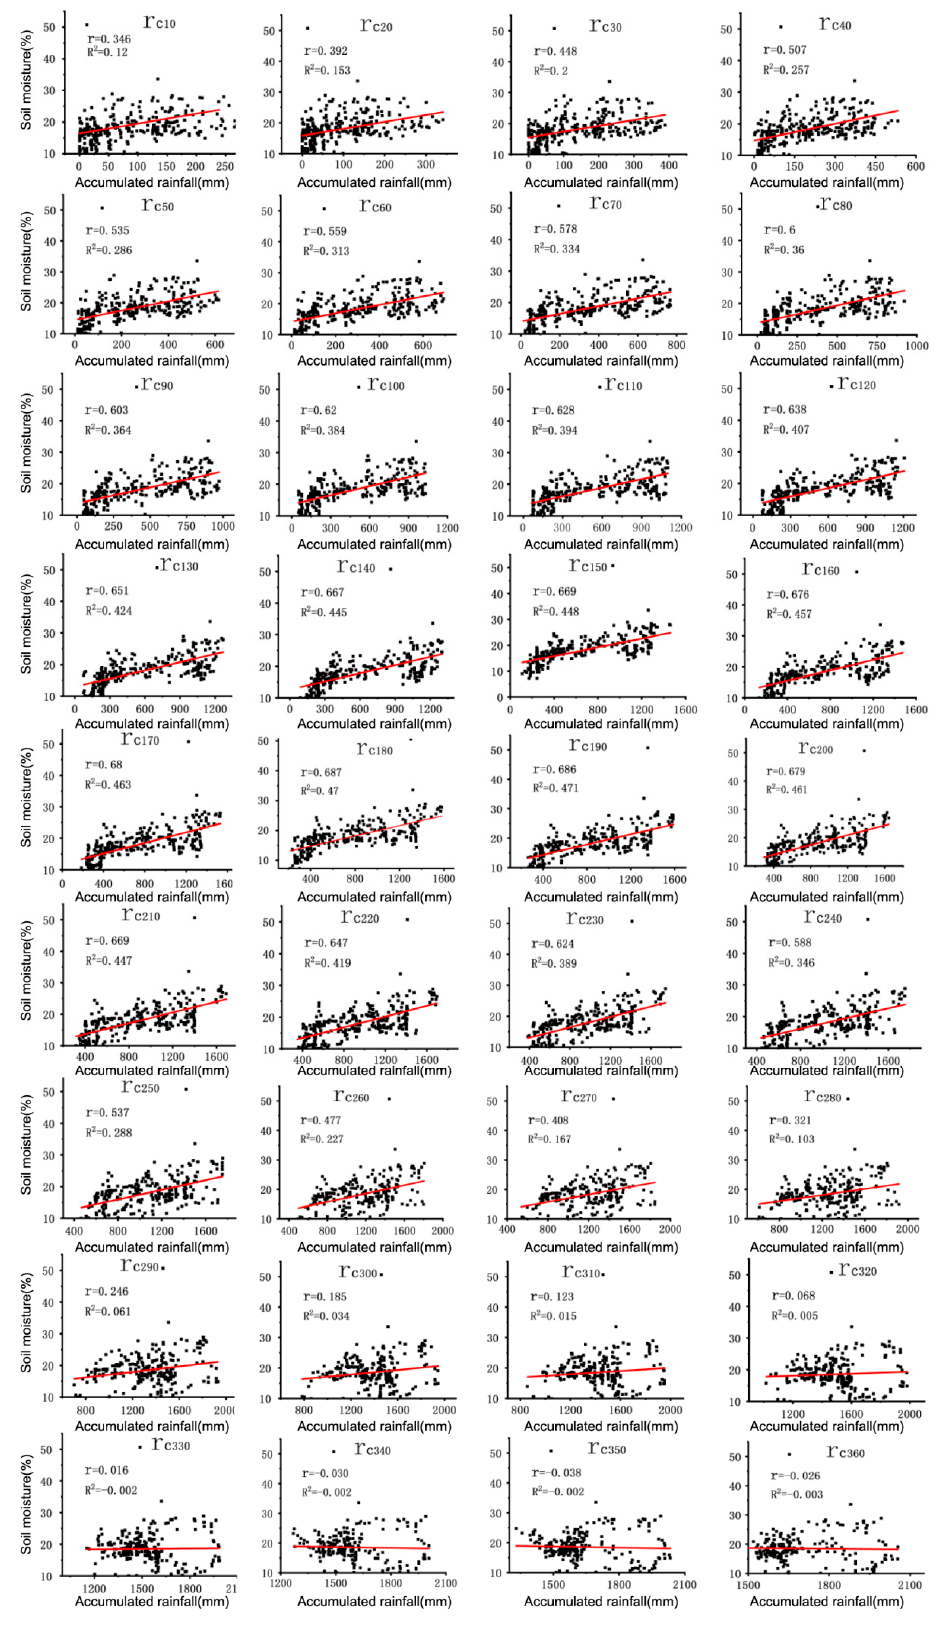
Figure 10. The linear relationship between accumulated precipitation and soil moisture content at 40 cm in arbors forest land.